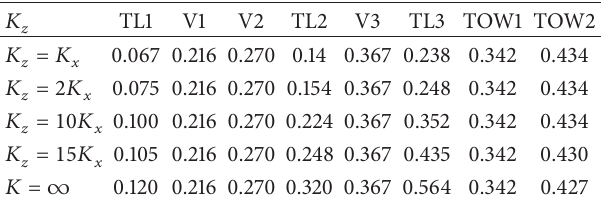
Table 5: Comparison of natural frequencies (Hz) with changes in the transverse stiffness (𝐾 𝑧 ) of bearings.